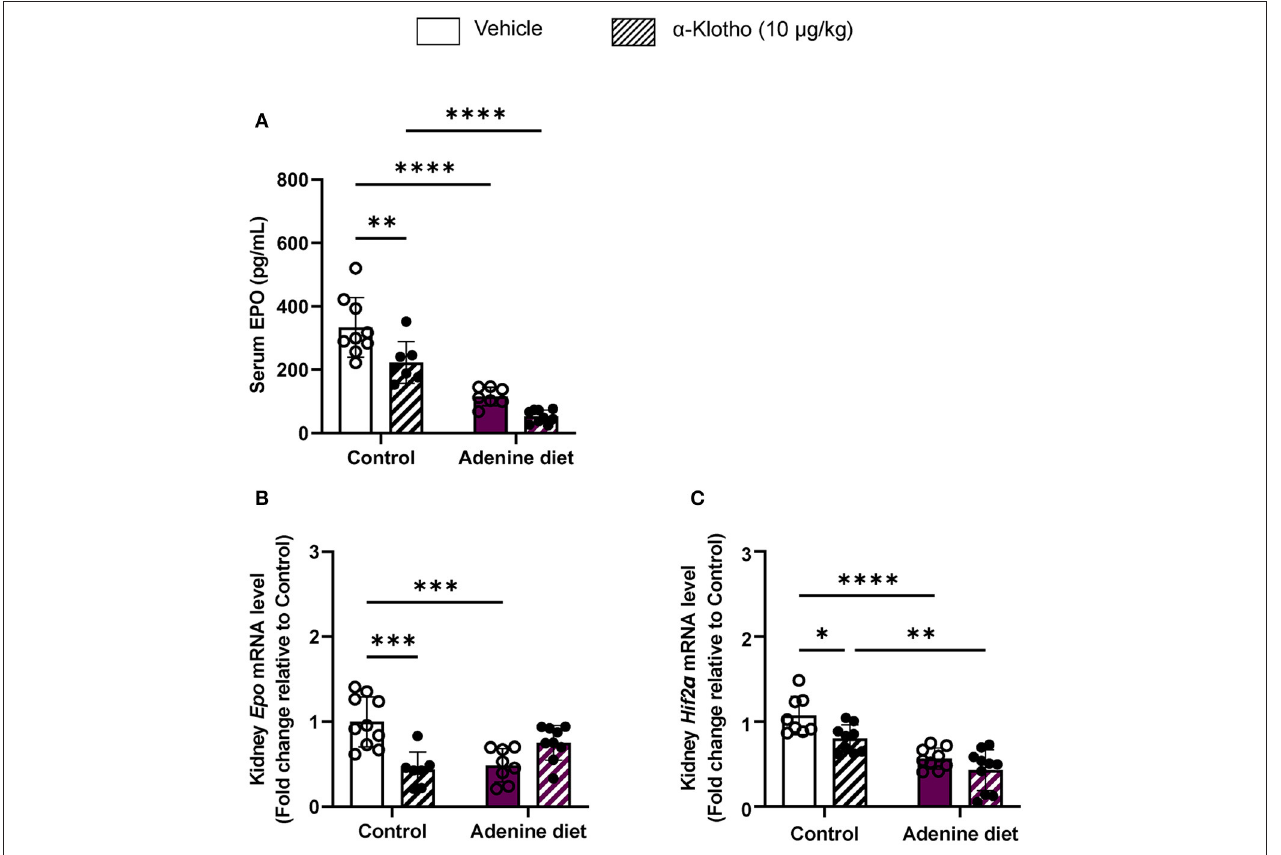
FIGURE 3 | Regulation of erythropoietin production by Klotho administration. C57BL/6J male mice were fed control diet or 0.2% adenine diet for 8 weeks, and further divided into 2 groups for administration of either saline or mouse recombinant Klotho protein (10 µ g/kg) 24h prior to sacrifice. (A) Serum erythropoietin (EPO) levels measured by ELISA. (B,C) Quantitative real-time RT-PCR for expression of (B) renal Epo, and (C) renal Hif-2 α . Data are expressed as fold change (2 − 11 Ct ) relative to housekeeping gene Hprt . Data are represented as mean ± SD ( n = 7–10 per group). * P < 0.05, ** P < 0.01, *** P < 0.001, **** P < 0.0001 compared to